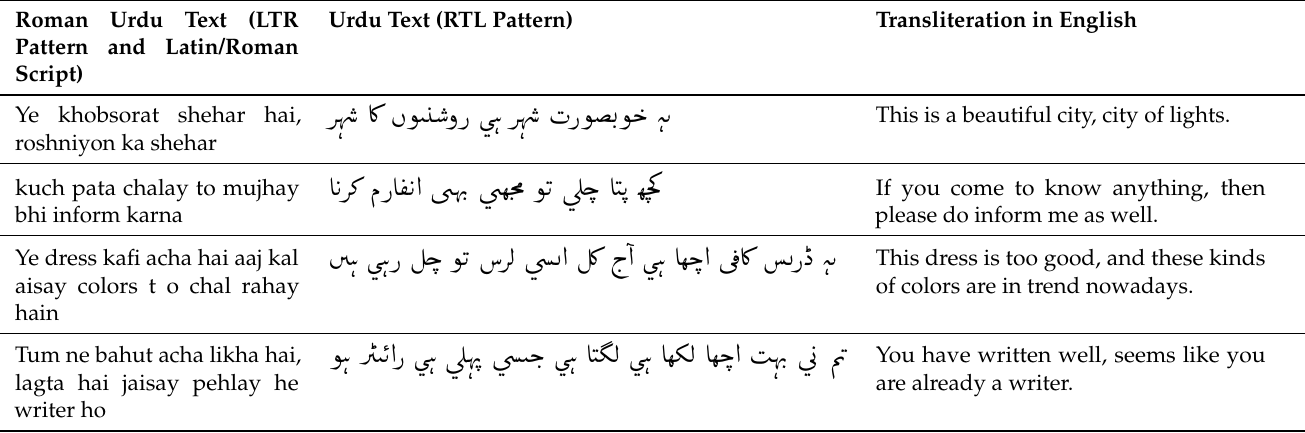
Table 1. Example of Roman Urdu